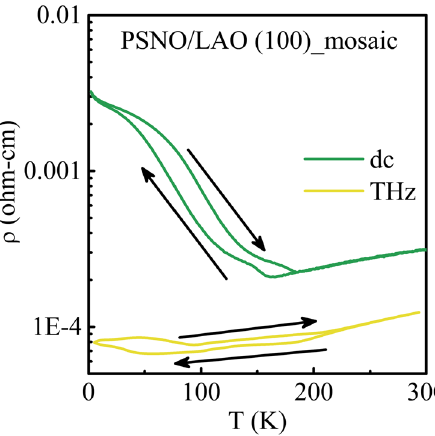
Fig. 5 Phase-coexistence in mosaic disordered fi lm. Comparative representation of resistivities for PSNO/LAO (100) mosaic fi lm, obtained through dc transport and THz-TDS (at 1 THz). Arrows show the path followed by data-points in heating and cooling